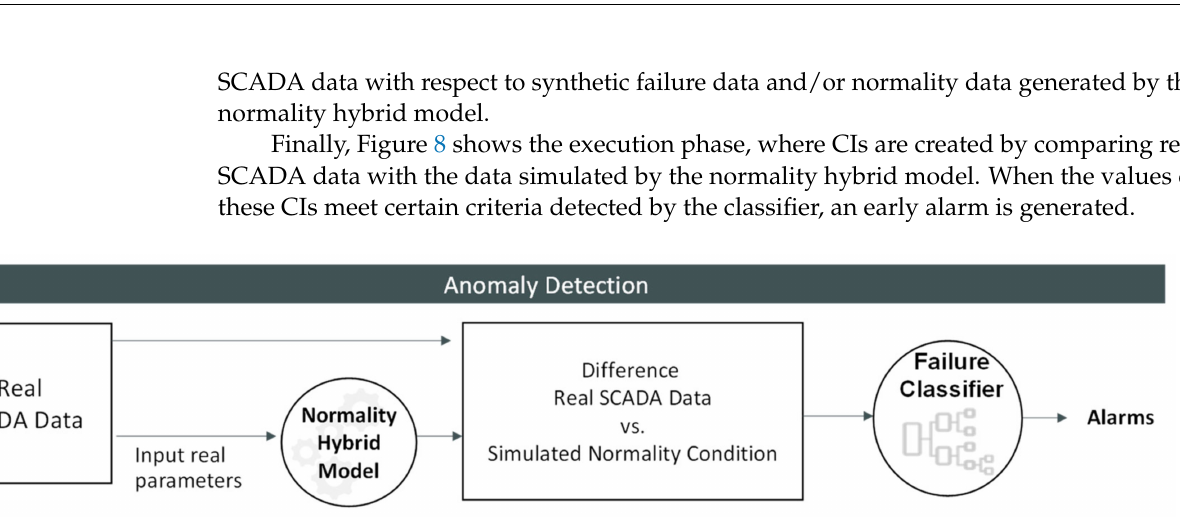
Figure 8. Execution phase of the developed classifier for anomaly diagnosis.